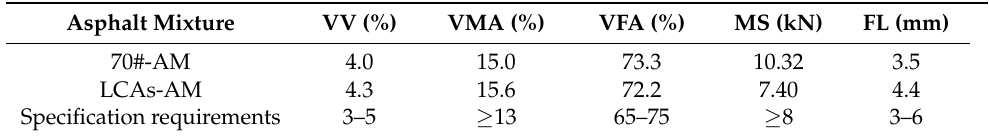
Table 9. Comparison of volumetric properties and mechanical performance between 70#-AM and